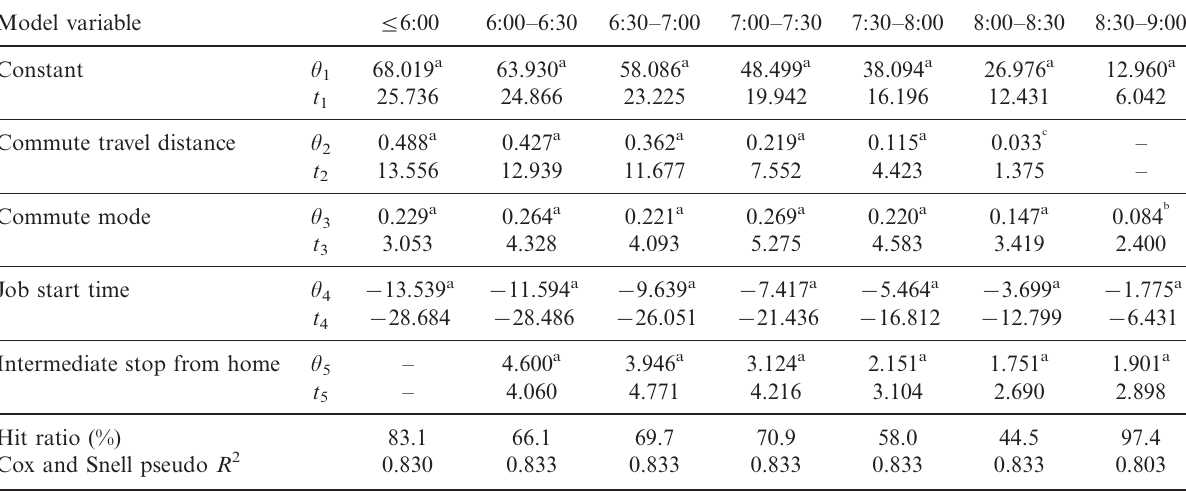
Table 6. Estimation results of the departure time choice model Model variable